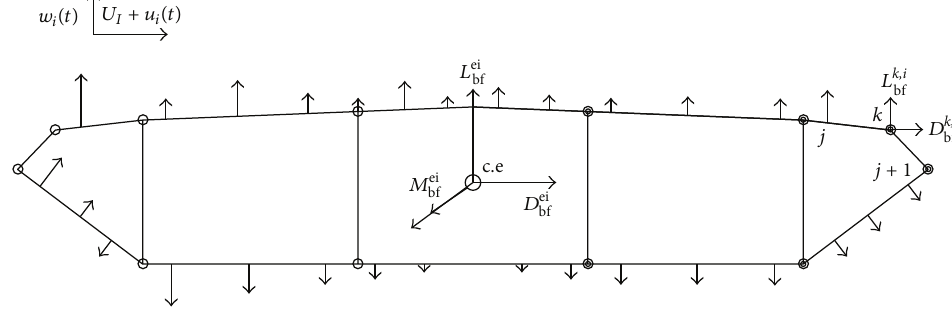
Figure 7: Buffeting wind pressures and buffeting forces at nodes